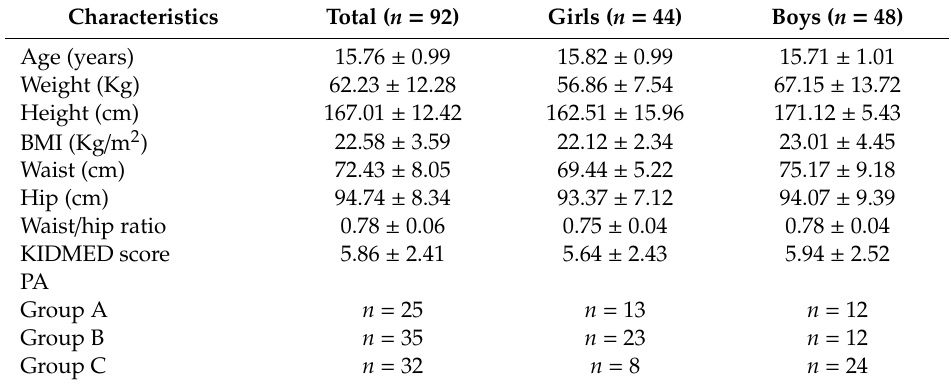
Table 1. Anthropometric characteristics, Mediterranean diet adherence (KIDMED), and physical activity levels of all participants and di ff erentiated by